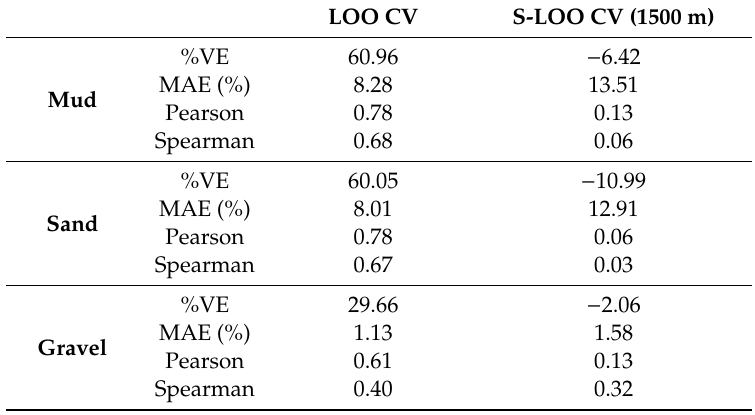
Accuracies of unclassified quantitative grain size predictions using spatial and non-spatial